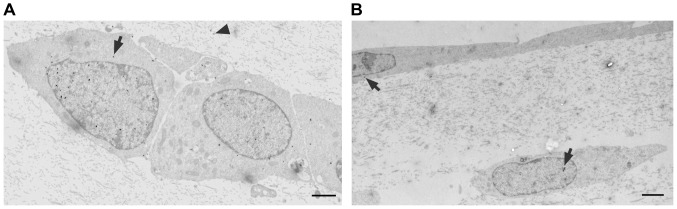
Presence of glucose-coated gold nanoparticles in primary human astrocytes and/or brain endothelial cells hCMEC/D3 in 3D collagen gels.(a) Astrocyte culture 8 hours after application of glucose-coated gold nanoparticles to the gel surface. Nanoparticles are visible both in the gel matrix and the astrocytes (arrows). (b) Co-culture of astrocytes and hCMEC/D3 cells 8 hours after application of glucose-coated gold nanoparticles to the endothelial surface. Nanoparticles are detected both in the endothelium and the astrocyte (arrows). Small tears in the gel matrix are sometimes produced during the sectioning due to the presence of silver-enhanced gold nanoparticles. Scale bars = 500 nm.